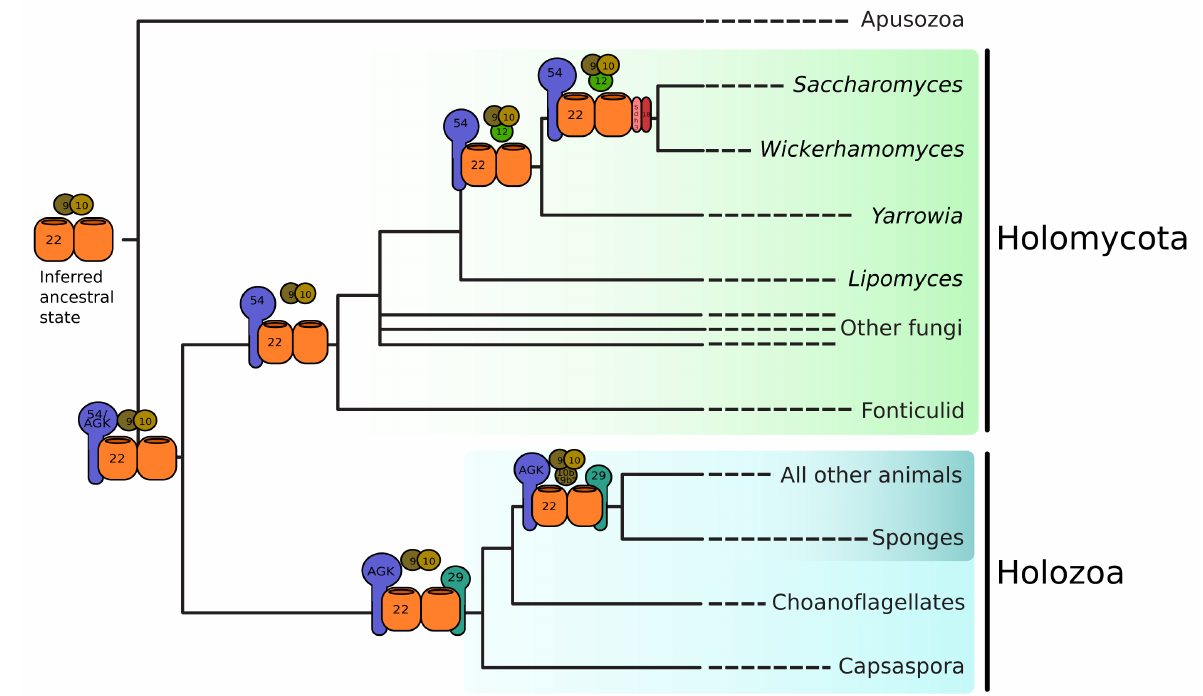
Figure 4. TIM22 complex subunits were gained independently in the animal and fungal lineages. The ancestral TIM22 complex comprises a single subunit, Tim22, which likely interacted with the small Tims, Tim9 and Tim10. The ancestral opisthokont TIM22 complex contained an additional subunit, AGK, which retains a diacylglycerol kinase (DAGK) domain in holozoans. In the holomycotan lineage, the DAGK domain was lost or diverged beyond recognition, but stabilized into Tim54, which is well-conserved across Holomycota. Early in the evolution of Saccharomycotina, Tim12 was gained via a duplication of Tim10, and Tim18 was gained via a duplication of Sdh4. Shortly after the divergence of Holozoa from Holomycota, Tim29 was gained as a subunit of the TIM22 complex. Tim10b was gained after the divergence of Metazoa from the unicellular holozoans from a duplication of Tim9. Tim8a and Tim8b result from a duplication of Tim8 in the lineage leading to chordates (not